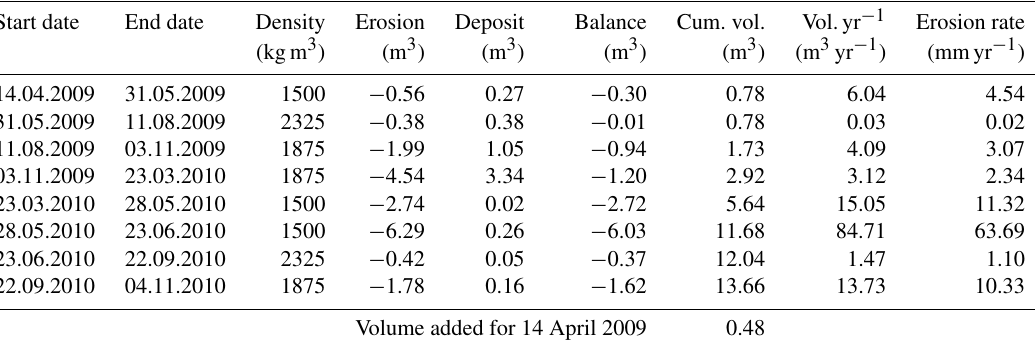
Figure 3. Typical pattern of slope activity (erosion in orange; deposition in blue) for each predefined season. The red outline indicates the boundary of the catchment (see also the video in the Supplement). Table 2. Measured volume of erosion and deposition. In order to perform a comparison with Table 3, 0.48m 3 have been added to the cumulative volume of the first